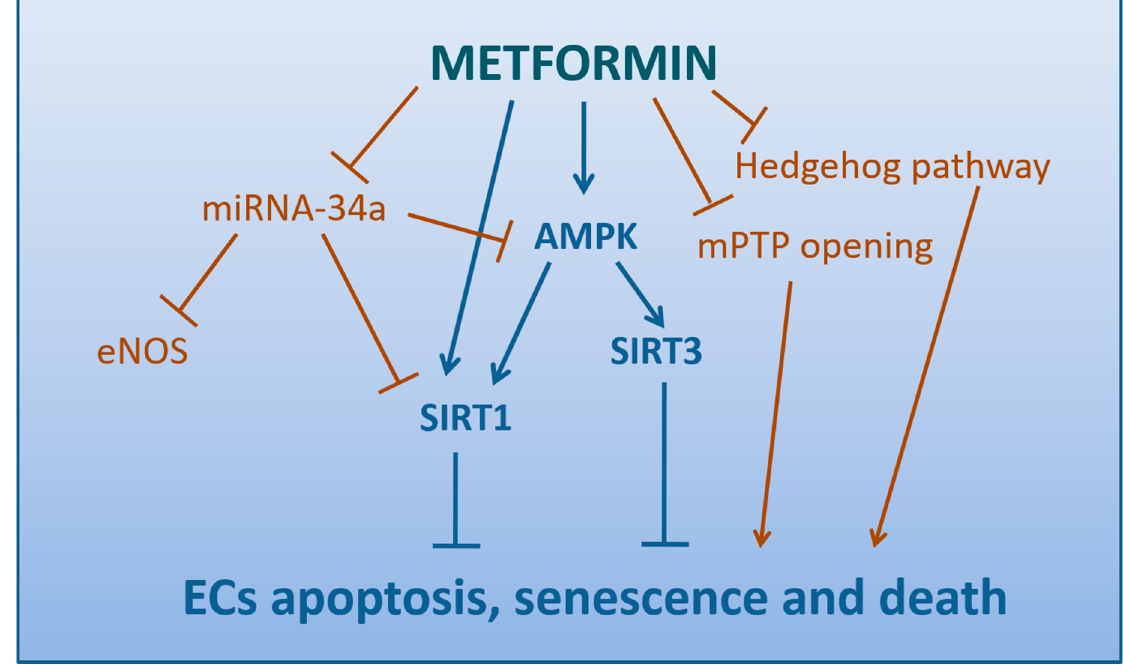
Figure 4. Mechanisms by which Metformin protect Endothelial Cells from apoptosis, senescence, and death (direct arrows indicate the direction of the pathway, whilst blocked arrows stands for inhibition of that specific pathway).